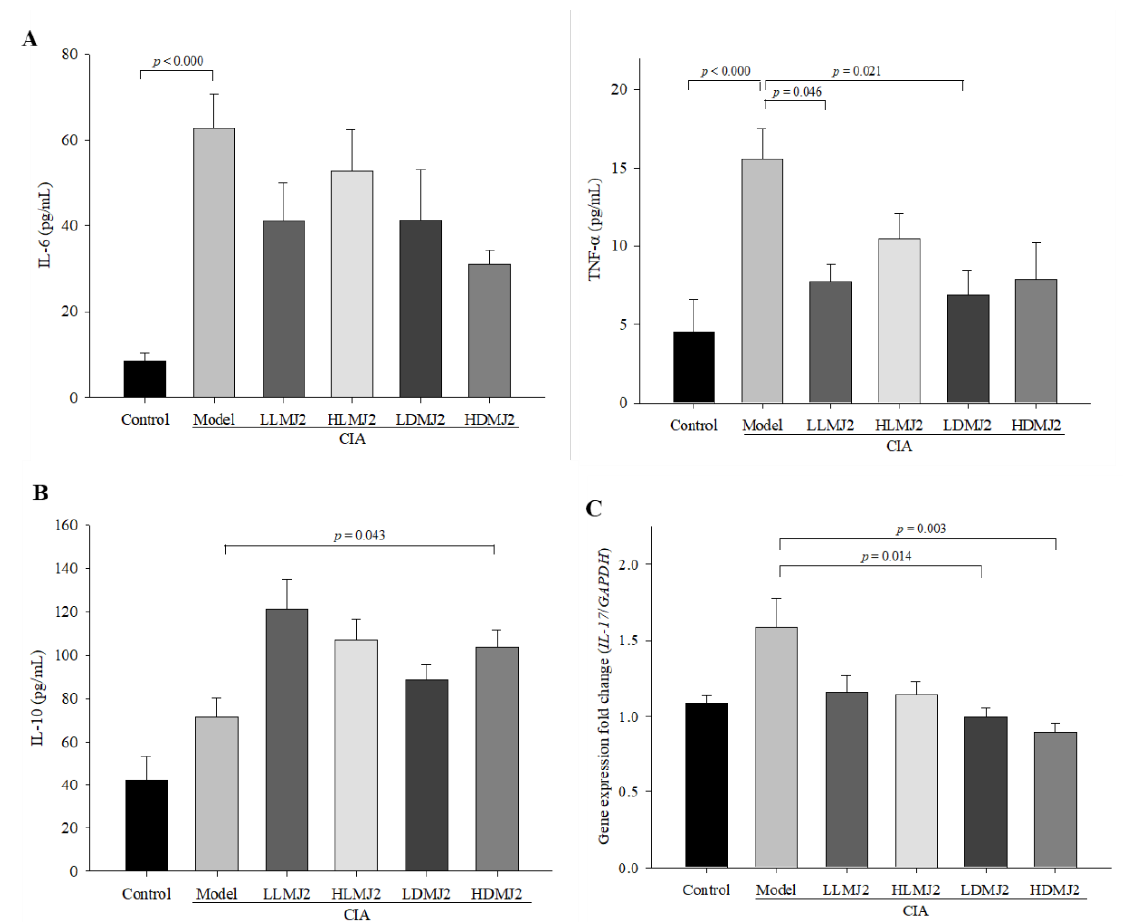
Figure 6. Effect of MJ2 on the expression levels of pro-inflammatory and anti-inflammatory cytokines in CIA mice ( n = 8 per group). Protein levels of pro-inflammatory ( A ) and anti-inflammatory ( B ) cytokines were measured in mice serum by ELISA. Gene expression levels of IL-17 were measured in the knee joint of mice by qPCR ( C ). Data values indicate the mean ± standard error of the mean (SEM). One way ANOVA followed by Tukey’s HSD was used to determine significance. CIA,